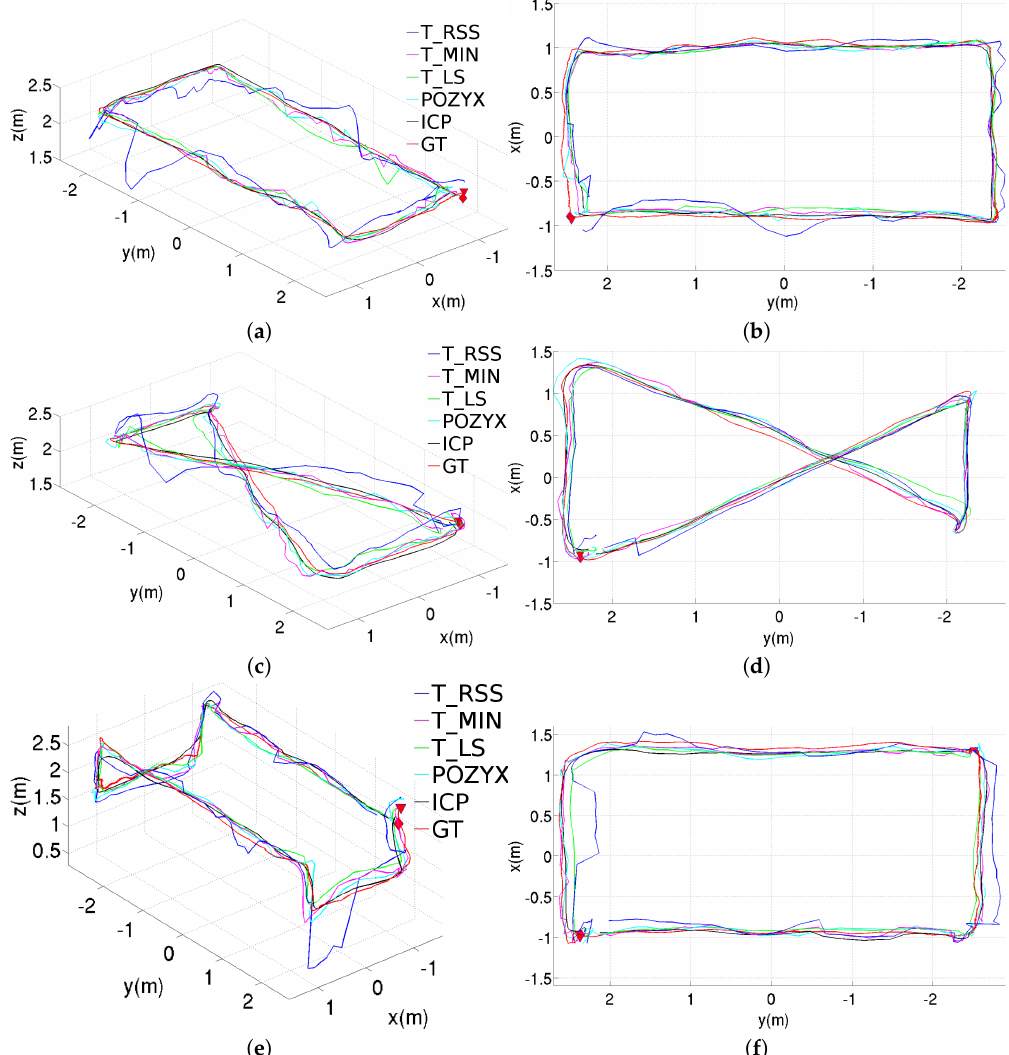
Figure 8. Position estimations provided by the different methods for the three trajectories performed inside the laboratory, results obtained using the pre-filtering stage: ( a ) perspective and ( b ) top views for the rectangular trajectory; ( c ) perspective and ( d ) top views for the figure-eight-like trajectory; ( e ) perspective and ( f ) top views for the rectangular trajectory with changes in